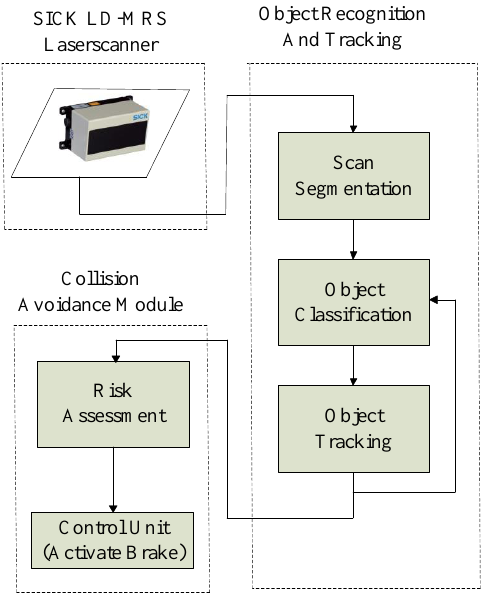
Figure 2. Outline of the proposed collision avoidance system (CAS).